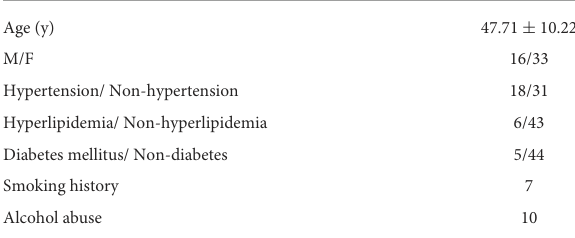
TABLE 1 Baseline data of 49 patients with second endovascular